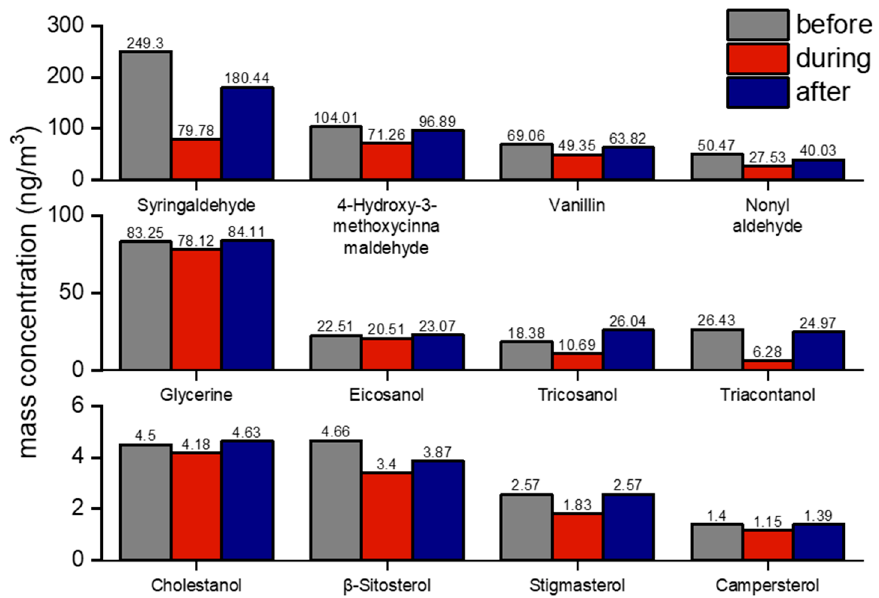
Figure 6. Average concentrations for aldehydes, alkanols, and sterols categories in three time periods. The concentration data are marked on the column bars.